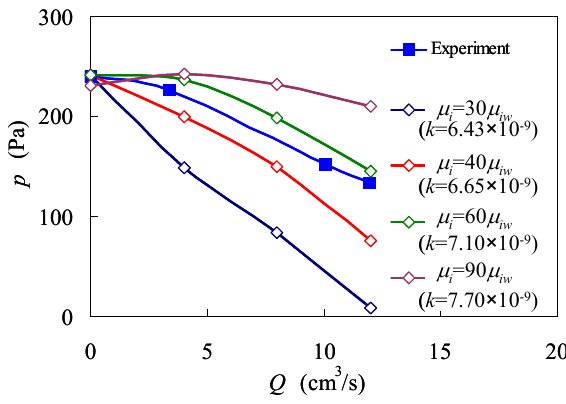
Fig.6 Effect of ionic mobility on pressure-flowrate characteristic ( V =10kV, unit of k is C/(V ･ m 2